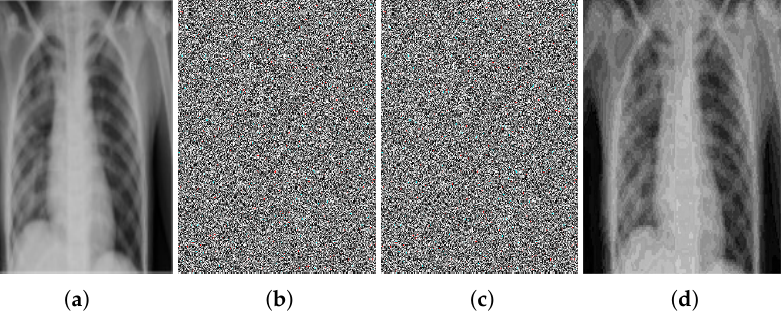
Figure 7. Noise attack analysis: ( a ) plaintext image, ( b ) encrypted image, ( c ) noisy encrypted image, ( d ) decrypted